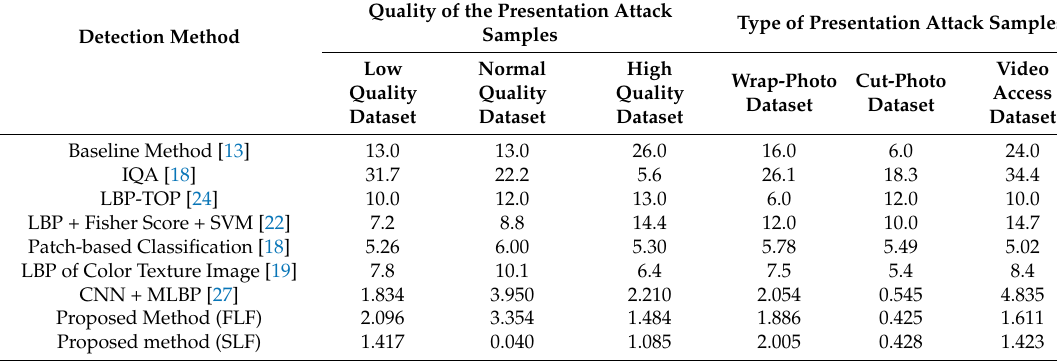
Table 8. Detection errors (ACERs) of various face-PAD methods using a subset of the CASIA dataset according to the quality and type of presentation attack samples (unit: %).